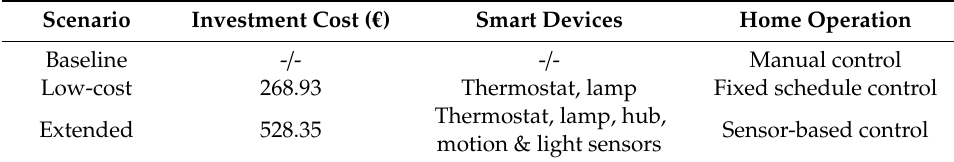
Table 3. Simulated Scenarios: Costs and